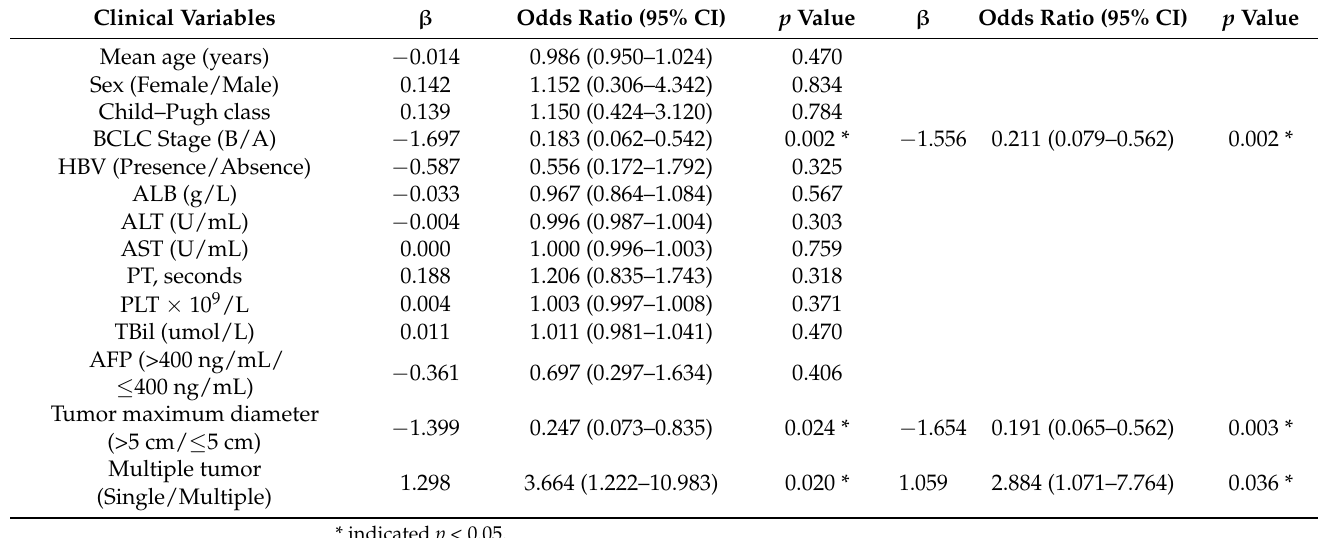
Table 3. Uni- and multivariable regression analysis of predictors of OR in the training cohort.